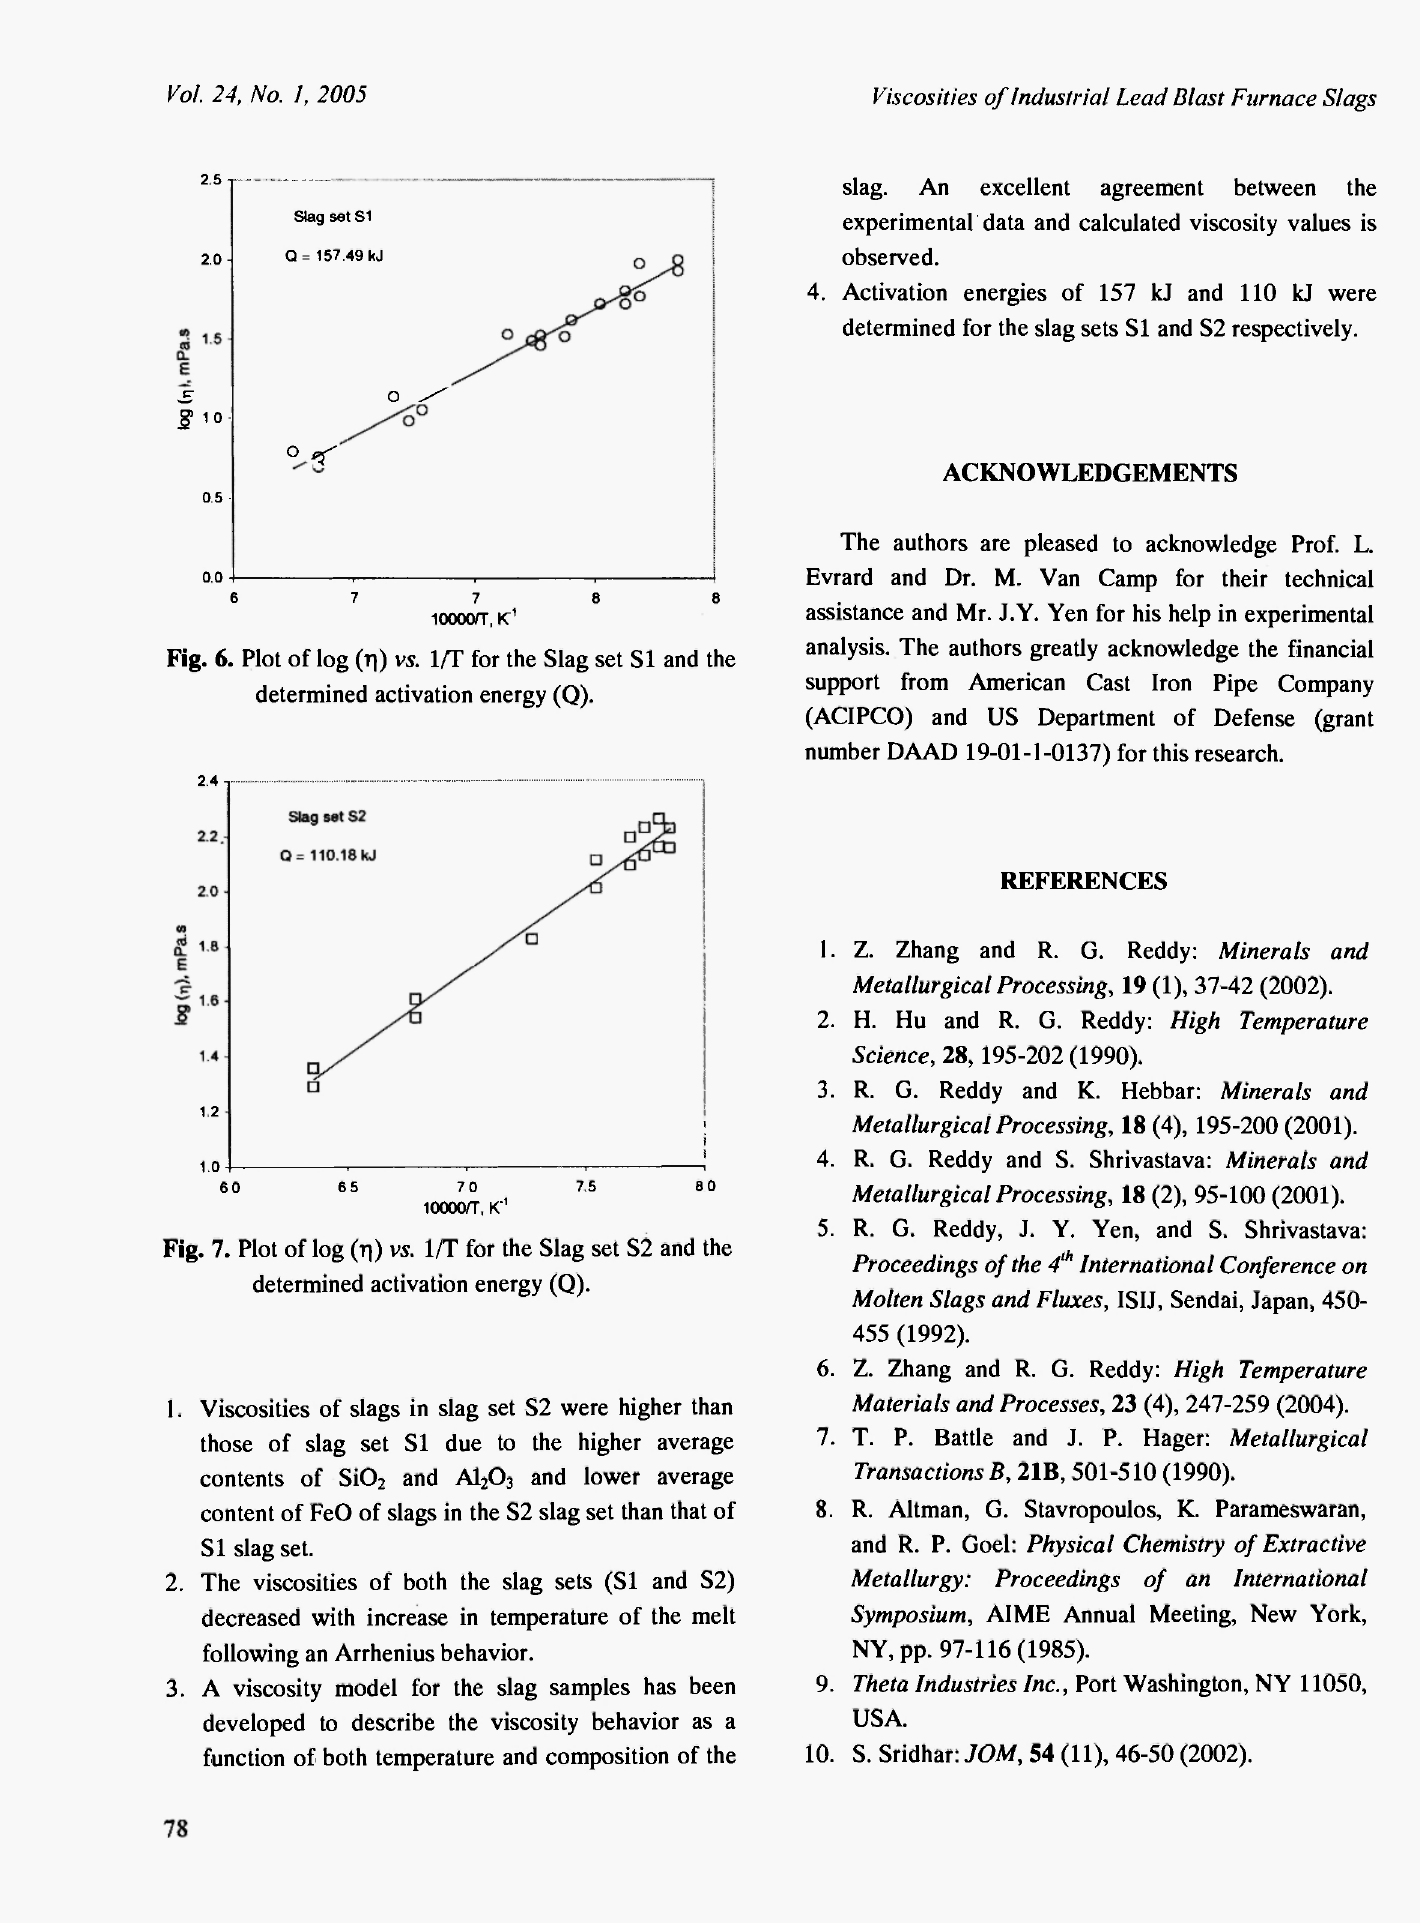
Fig. 7. Plot of log (η) vs. 1/T for the Slag set S2 and the determined activation energy (Q).